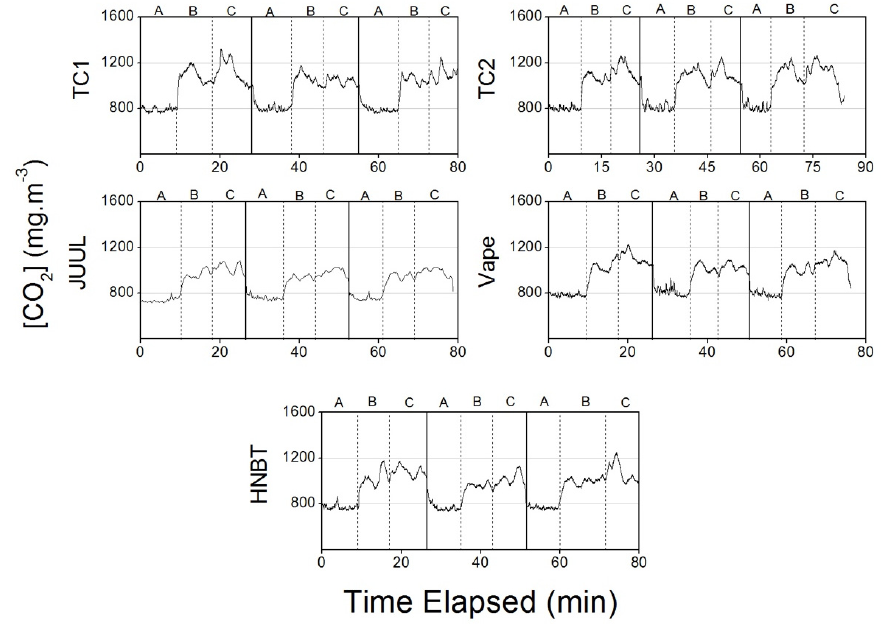
Figure 10. Carbon dioxide concentrations measured in the car during traditional cigarette (TC1 and TC2), e-cigarette (JUUL and Vape) and heat-not-burn tobacco (HNBT) TC2), e-cigarette (JUUL and Vape) and heat-not-burn tobacco (HNBT) consumption. Goh et al. [49] measured CO 2 concentrations ranging between 810 and 1080 mg·m − 3 in cars, similar to the results for the cleaning laps in the present study. The same study obtained CO 2 concentrations for two occupants (with all the windows closed) of 2160 mg·m − 3 nine minutes after measured in the present study for TC2 (1190 mg·m − 3 ).